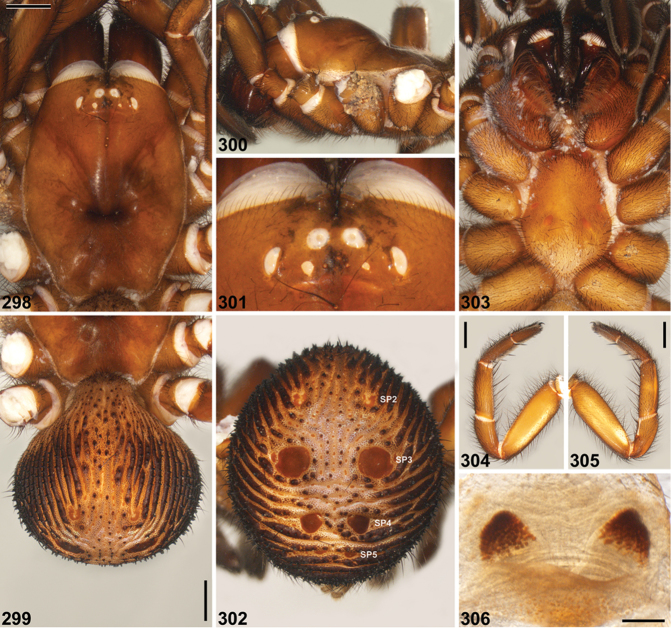

Idiosoma
mcclementsorum sp. n., female paratype (WAM T139469) from Julimar Conservation Park (Western Australia; JAF). 298–299 Carapace and abdomen, dorsal view 300 Carapace, lateral view 301 Eyes, dorsal view 302 Abdomen, posterior view 303 Sternum, ventral view 304 Leg I, prolateral view 305 Leg I, retrolateral view 306 Spermathecae, dorsal view. Scale bars 2.0 (298–299, 304–305), 0.5 (306). SP2–5 = sigilla pairs 2–5.